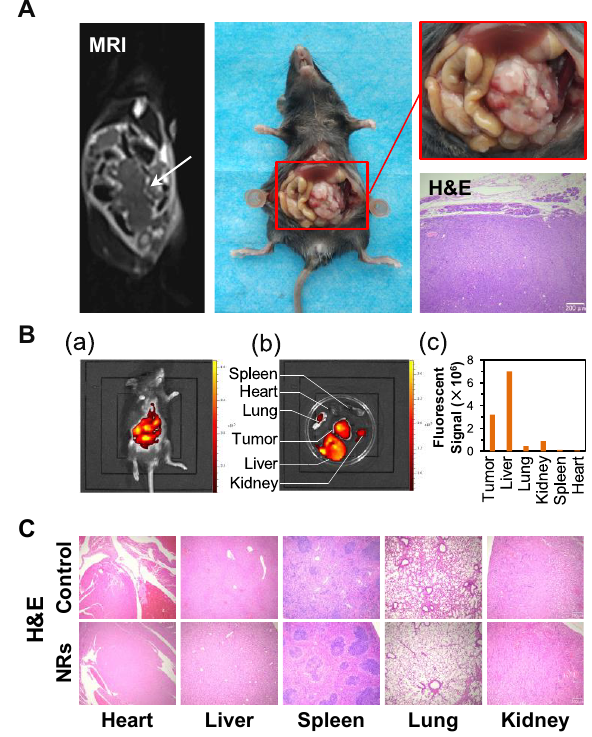
Figure 5: Biodistribution of Fe2P-PEG-Mal NRs. (A) T 2-weighted MR image (left, white arrows refer to tumor regions) and photographic image (middle) of orthotopic pancreatic tumor- bearing mice. H&E staining (lower right) of orthotopic pancreatic tumor. Scale bar: 200 μ m. (B) Fluorescence distribution of NRs 24 h afterintravenousinjection. (a)Fluorescence imagesof injectedmice in vivo. (b) Biological distribution of NRs in heart, liver, spleen, lung and kidney. (c) Bar graph based on the intensity of fl uorescent signals in (b). (C) H&E staining images of major organs collected from mice treated with or without NRs. Scale bar: 200 μ